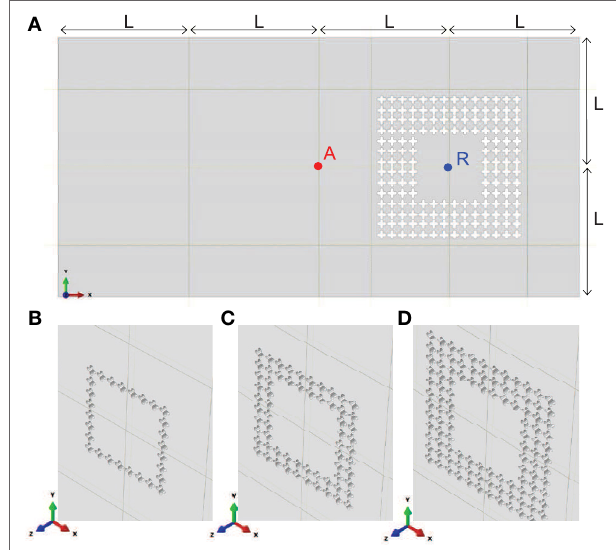
FigUre 5 | (a) Schematic representation of the numerical model of a plate including a four-row “ring-like” area in the right part of the plate. A zoom of the same structure with the “ring-like” zone made of (B) 1 row, (c) 2 rows, and (D) 3 rows of unit cells is provided. A and R denote the Lamb wave excitation and receiving points, respectively. L = 250 mm.